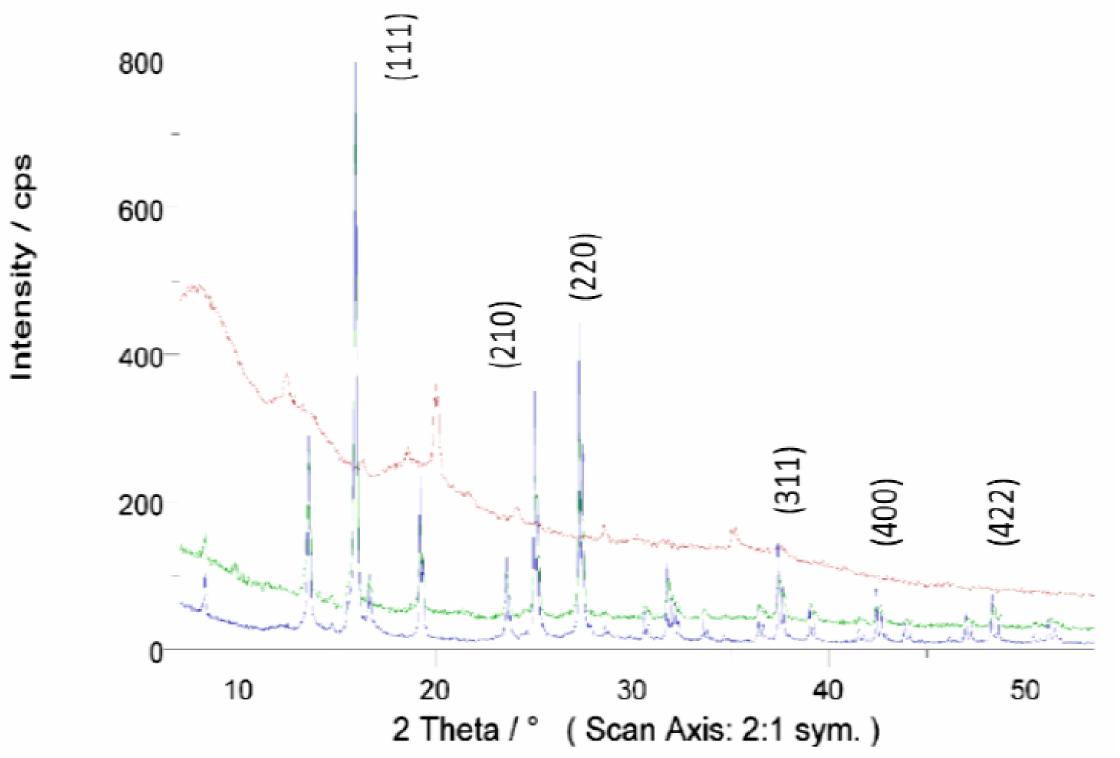
Figure 5. XRD of toner samples U (red), S (green) and M